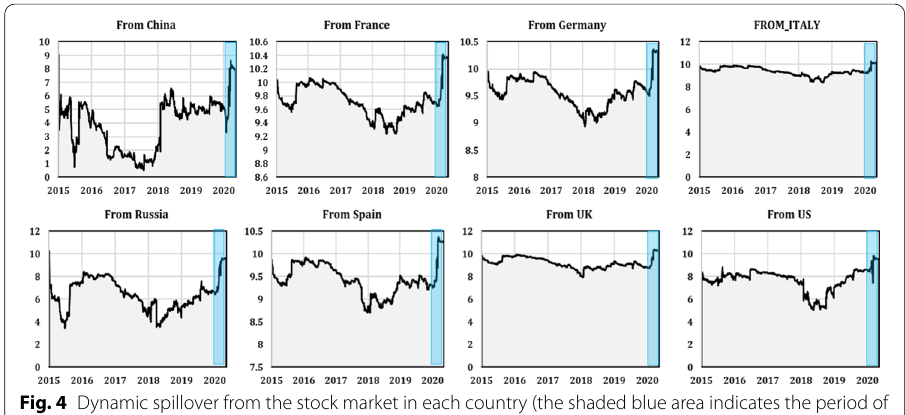
Fig. 4 Dynamic spillover from the stock market in each country (the shaded blue area indicates the period of the COVID-19